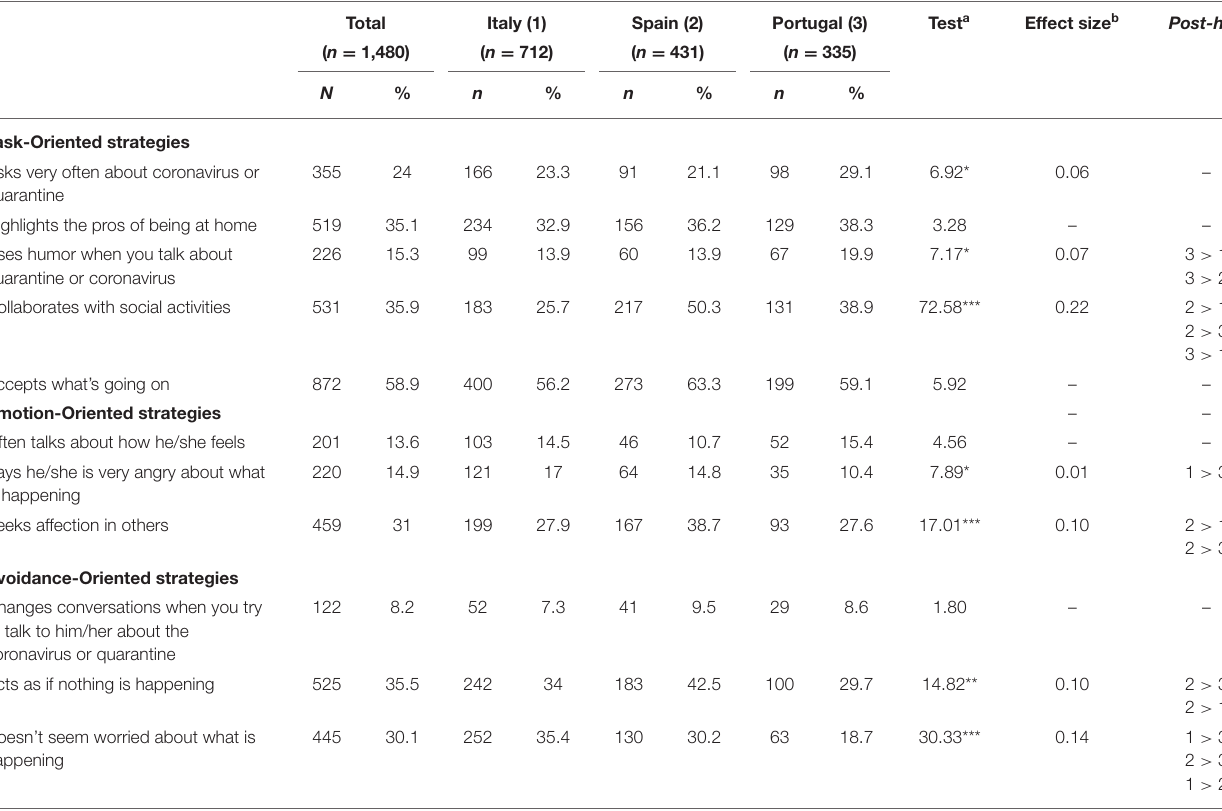
TABLE 2 | Coping strategies by country.